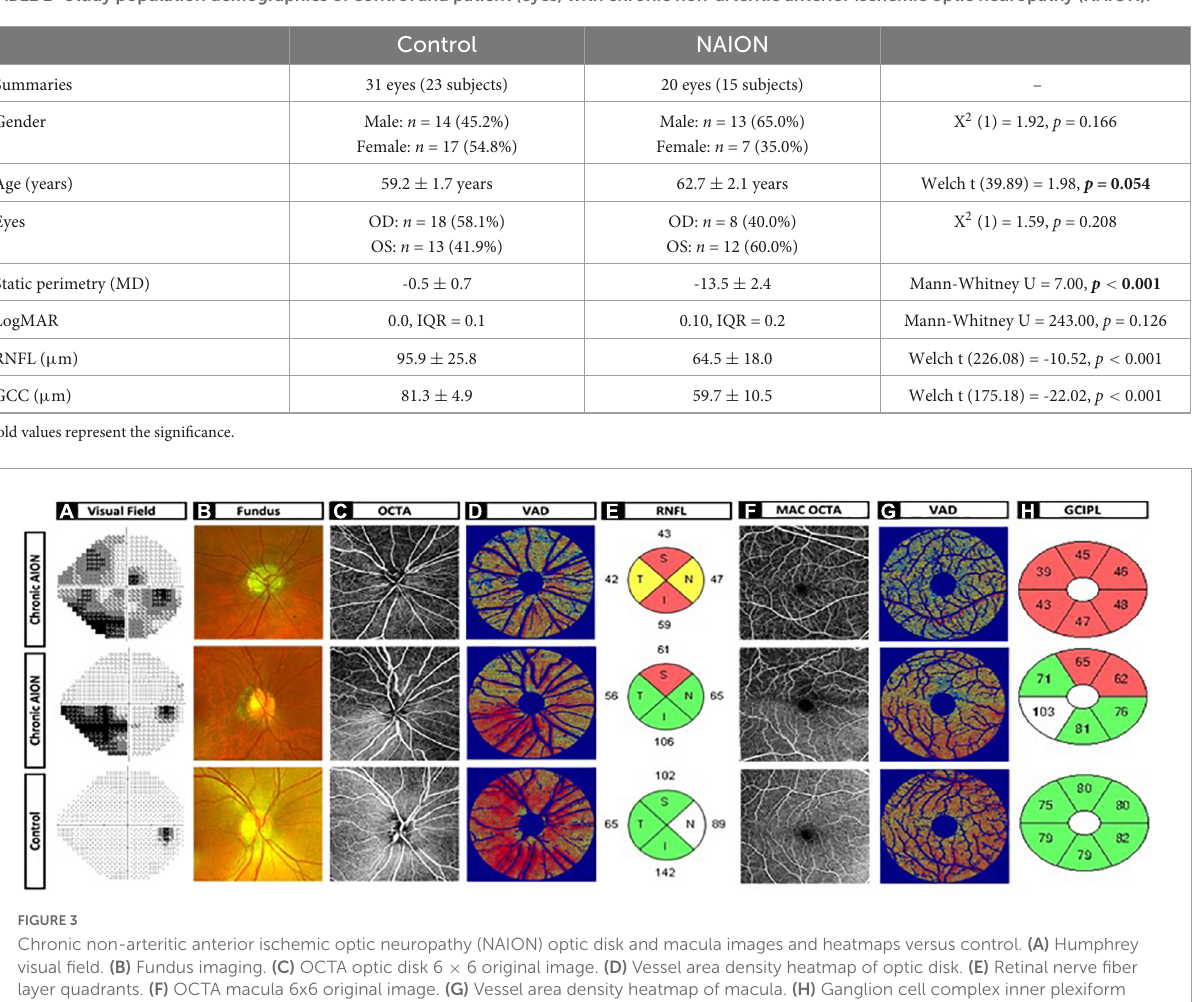
thinning of RNFL and GCC (72 and 76 µ m, respectively), and superior drop out of peripapillary ( Figure 2B , middle row) and macular SCP vasculature ( Figure 3